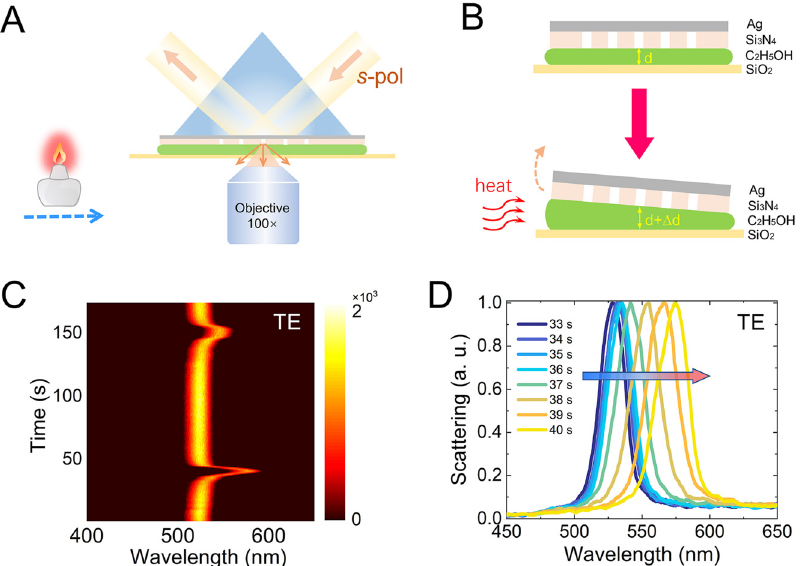
Figure6: (A)Schematicshowingthesensingexperimentcarriedoutinthiswork.TheSi 3 N 4 /Agheterostructurewascoveredbyanalcohol fi lm andaglassslide.TheTEwavesupportedbytheSi 3 N 4 /Agheterostructurewasexcitedby s -polarizedandscatteredintofar fi eldbyananohole. An alcohol lamp was moved toward and away from the sample. (B) Schematic showing the expansion of the alcohol fi lm with increasing temperature. (C) Two-dimensional scattering intensity as functions of wavelength and time measured for a Si 3 N 4 /Ag heterostructure covered with a thin alcohol fi lm. The alcohol lamp was moved close to and away from the sample at ∼ 36 and ∼ 150 s. (D) Evolution of the scattering spectrum observed in a time interval of 33 – 40